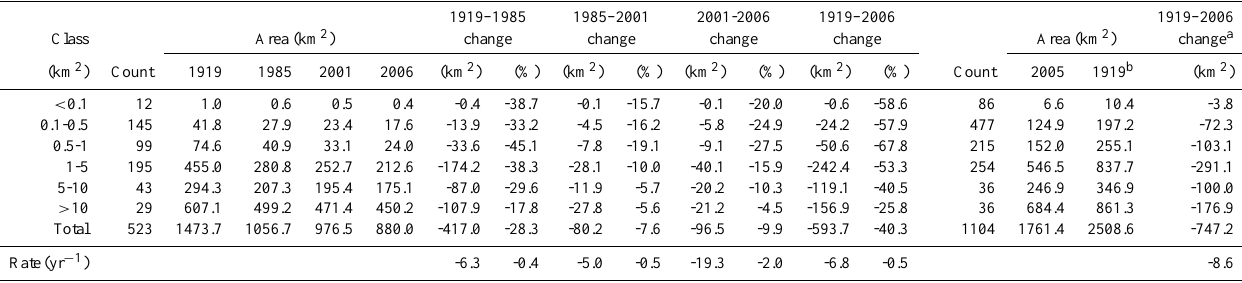
Table 3. Glacier data for the period 1919–2006.